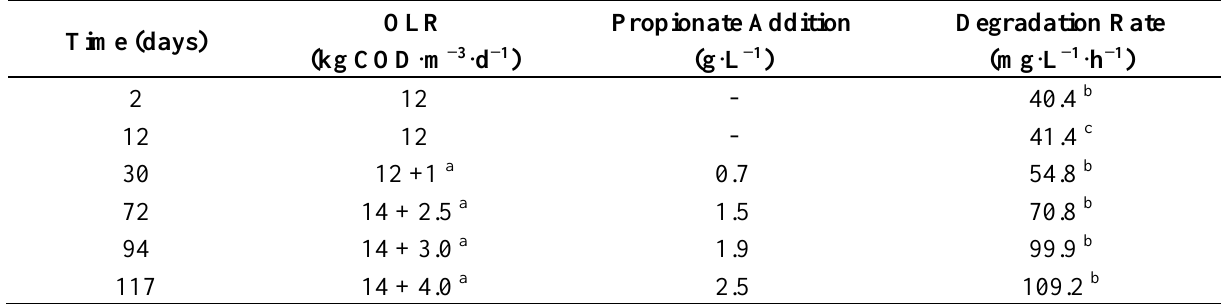
Figure 1. Scheme of reactors. Table 2. Propionate degradation rates in reactor 2 for biowaste at an OLR of 12/14 kg COD·m −3 ·d −1 and after a stepwise increase of the OLR to 18 kg COD·m −3 ·d −1 by co-feeding of